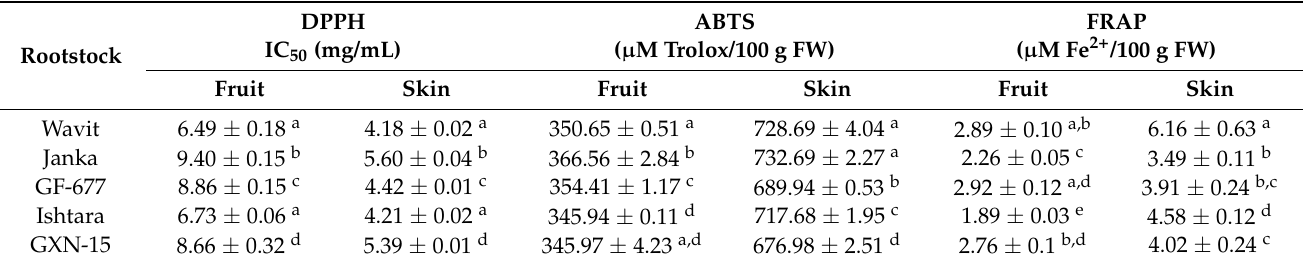
Table 5. Antioxidant potential (DPPH, ABTS, and FRAP) of fruit and fruit-skin extracts obtained from plums growing on different